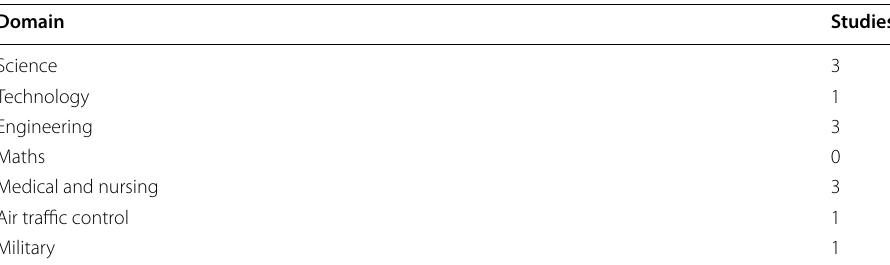
Fig. 3 Included studies per 5-years interval